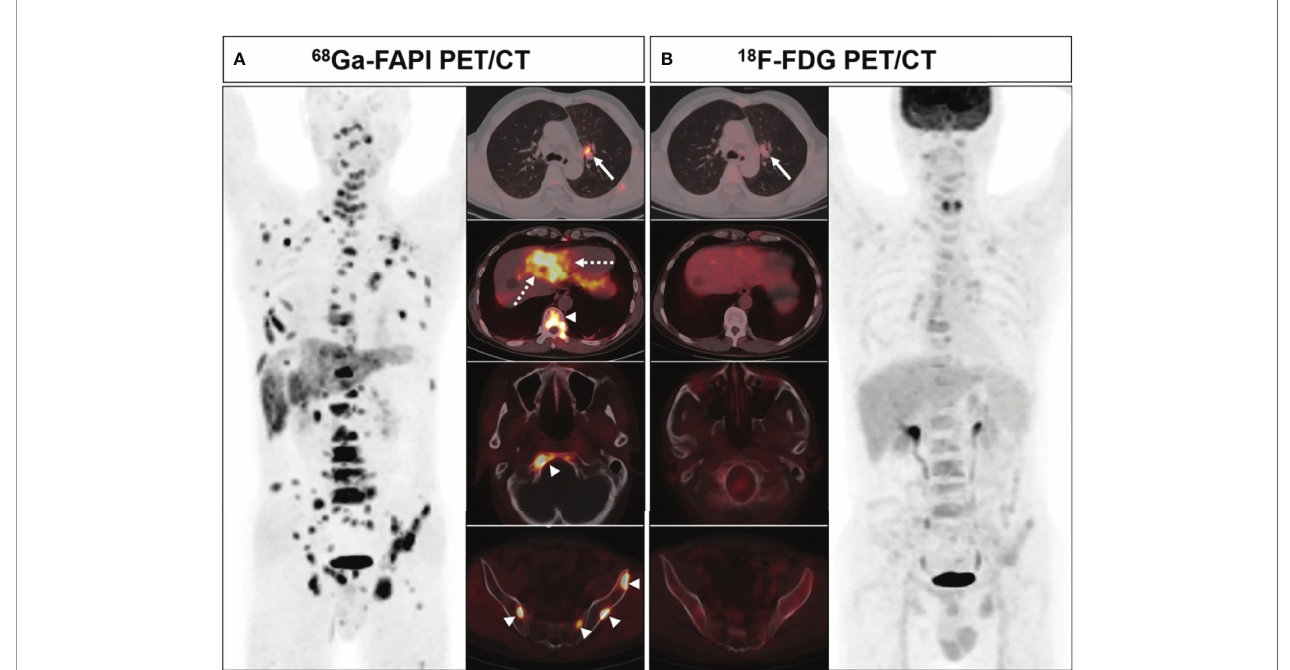
FIGURE 4 | A 63-year-old male (patient 18) diagnosed with adenocarcinoma. 68 Ga-FAPI PET/CT (A) showed intense tracer uptake in the primary tumor (solid arrows, SUVmax=10.0), liver metastasis (dashed arrows, SUVmax=7.6) and bone metastases (arrows, SUVmax=8.3-8.5). 18 F-FDG PET/CT (B) showed primary lesion with mild FDG uptake (solid arrows, SUVmax=3.6), while no signi fi cant FDG uptake was showed in liver metastasis and multiple bone